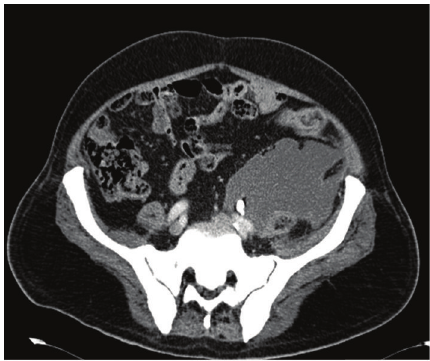
Figure 3: Abdomen CT scan: left urinoma, left ureteral stone, and left double J stent.